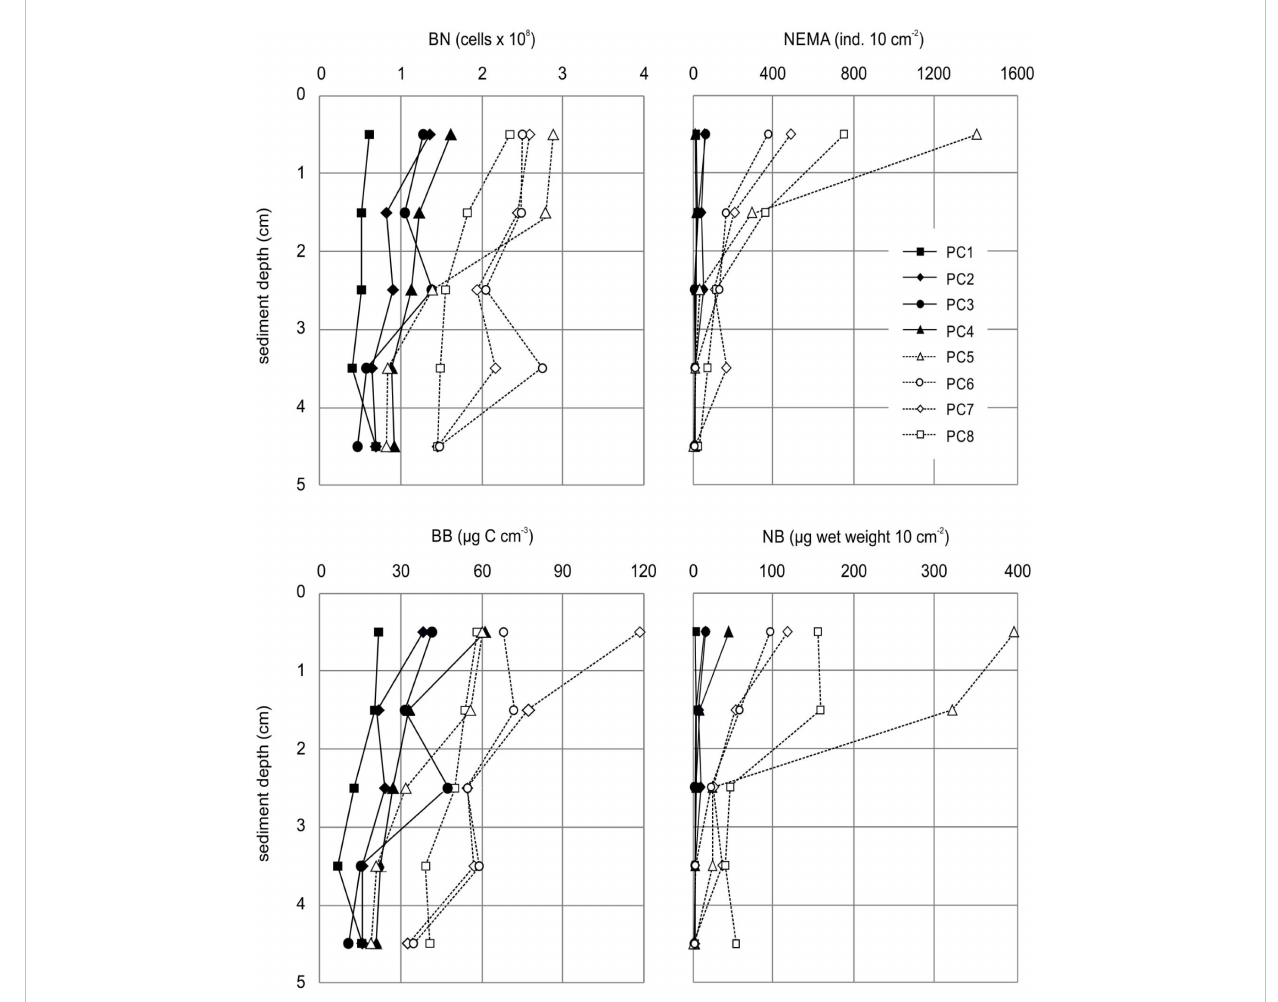
FIGURE 4 Gradients of bacterial numbers (BN; top left) and nematode densities (NEMA; top right) as well as bacterial biomass (BB; bottom left) and nematode biomass (NB; bottom right) in surface sediments along the transect with increasing distance from the corroding